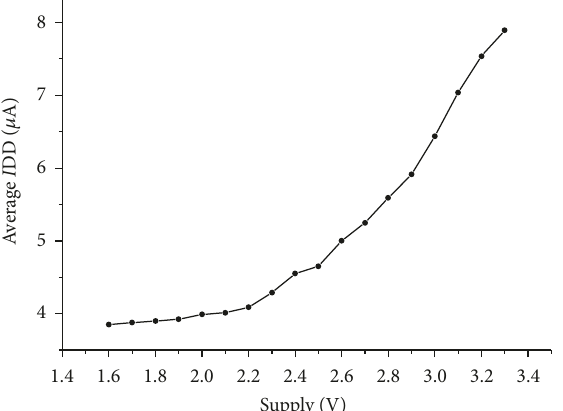
Table 2: Test of the Hall